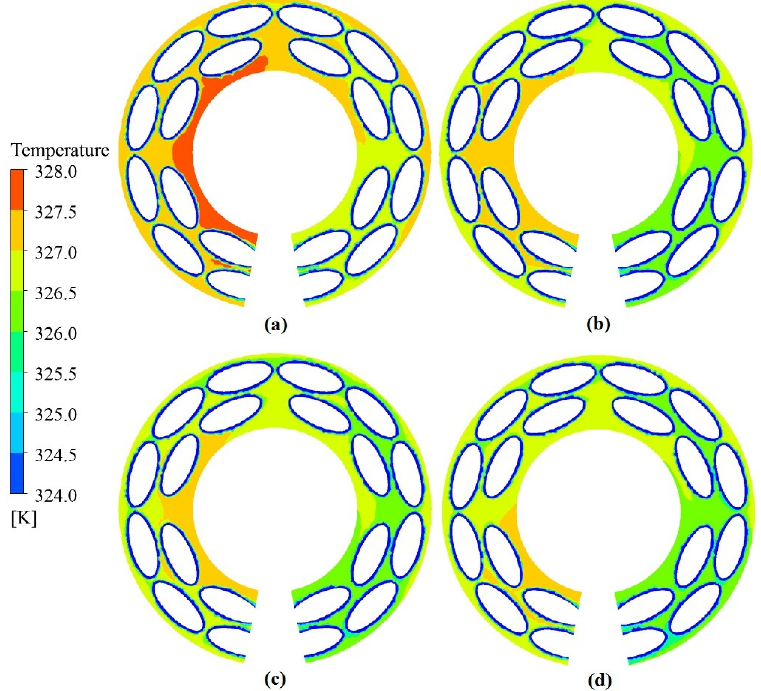
Figure 11. Shell-side temperature distributions of elliptic tube heat exchanger ( V f = 1.72 m 3 · h − 1 , Z = − 500 mm): ( a ) base fluid; ( b ) 0.2 wt % MWCNTs/XG; ( c ) 0.5 wt % MWCNTs/XG; and ( d ) 1.0 wt % MWCNTs/XG.